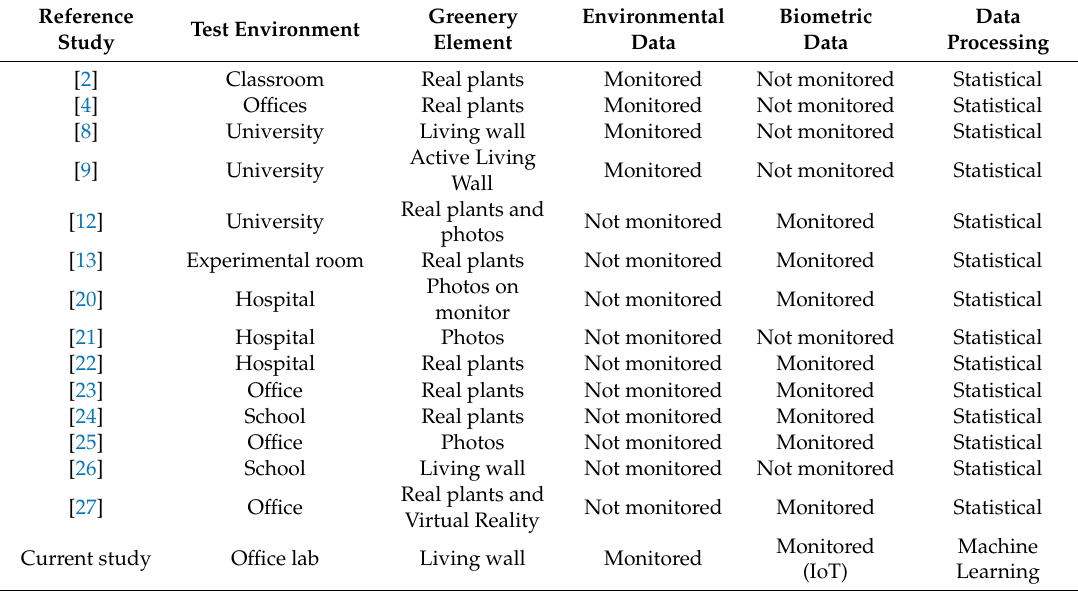
Table 1. Main features of the reference literature and proposed